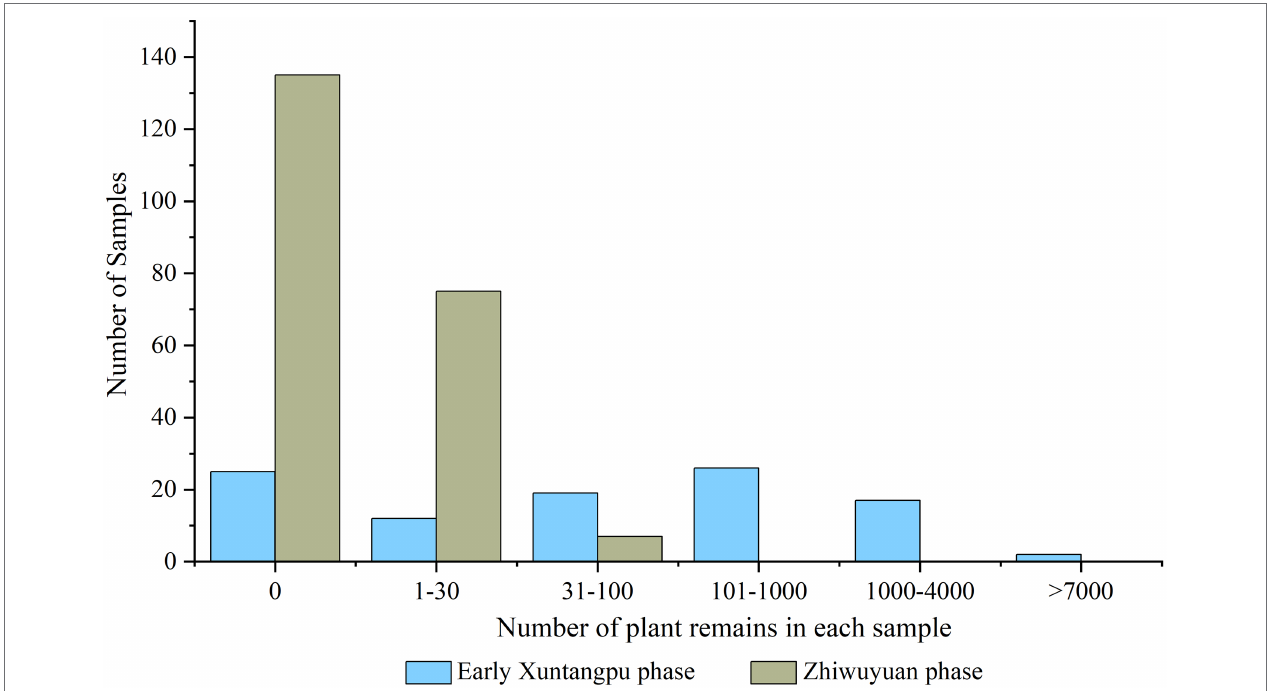
FIGURE 4 | Abundance distribution of plant remains from the Zhiwuyuan